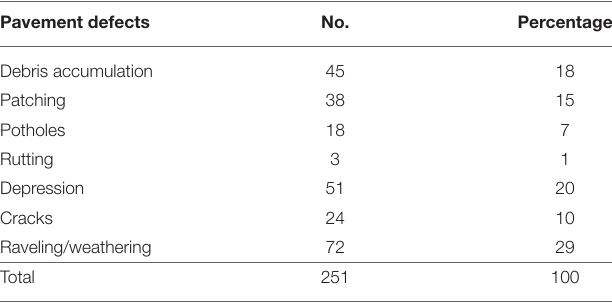
TABLE 3 | Types of pavement distresses near traffic calming measures. TABLE 4 | Distribution of casualty injury severity by collisions types on Abuakwa-Bibiani